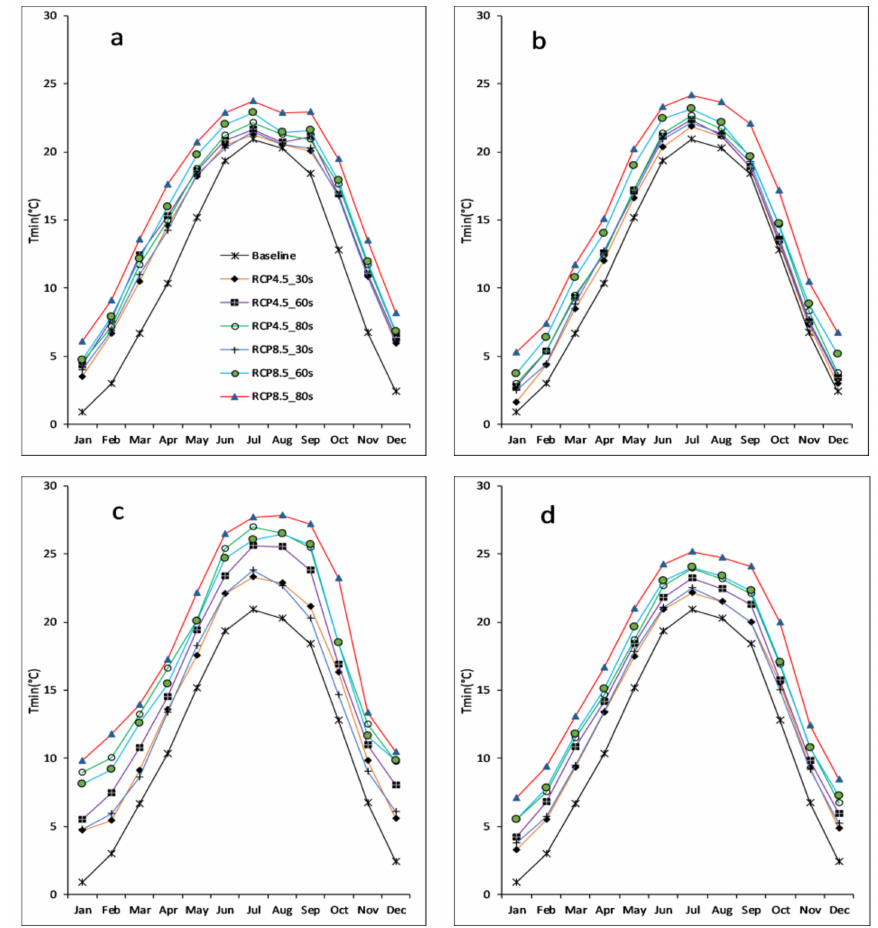
Figure 7. Comparison of monthly mean T min between the observed (1975–2005) and projected climate during the three future periods. ( a ) BCC-CSM1.1; ( b ) CCSM4; ( c ) MIROC-ESM; and ( d )